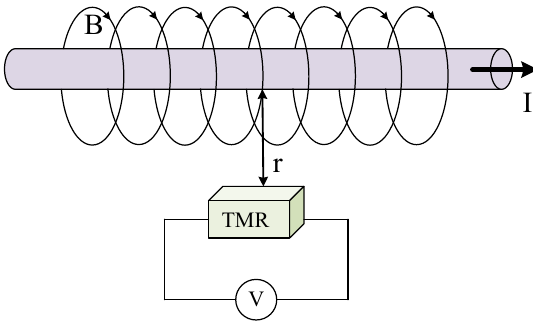
Figure 2. Measurement principle diagram of the TMR current sensor.